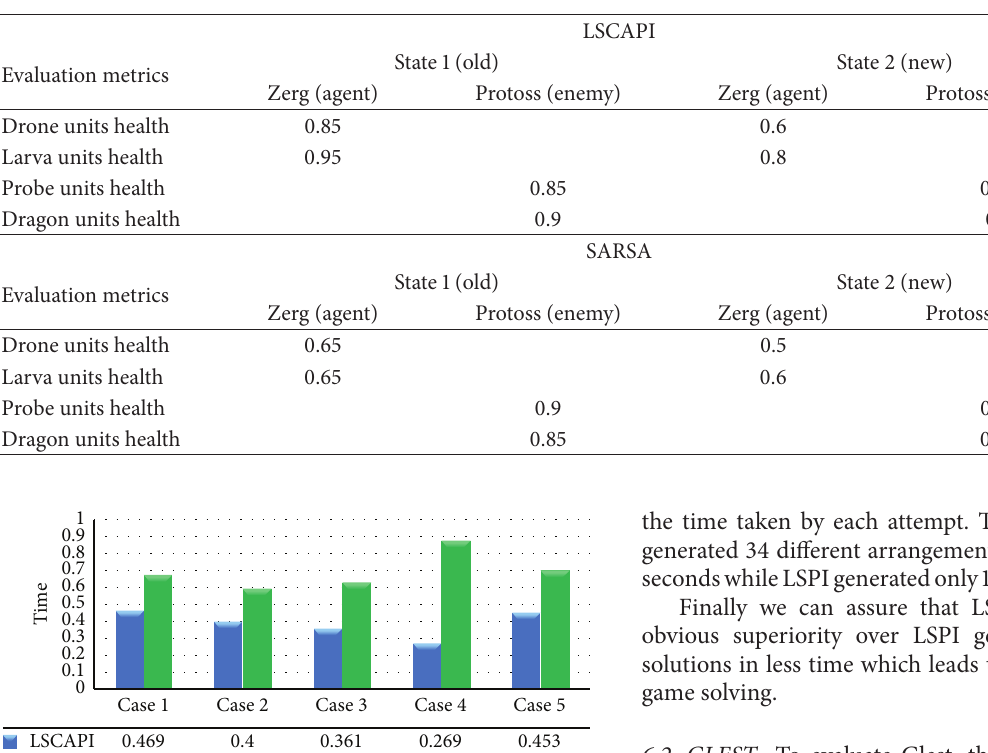
Table 7: Protoss versus Zerg Case.